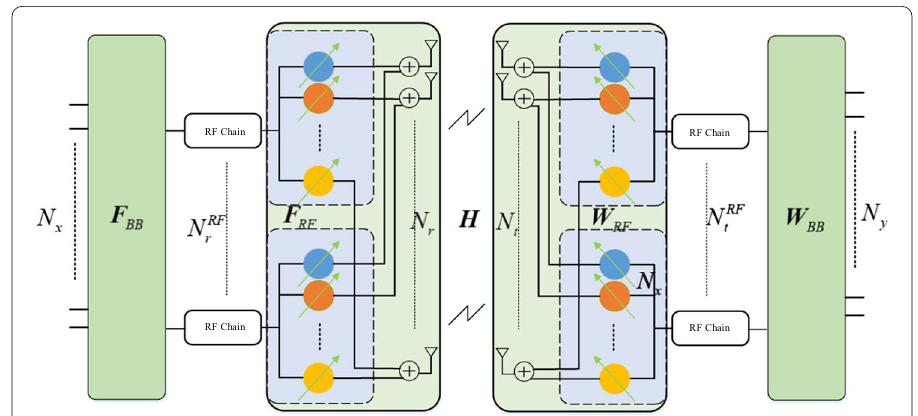
Fig. 1 A mm-wave system employing hybrid analog-digital